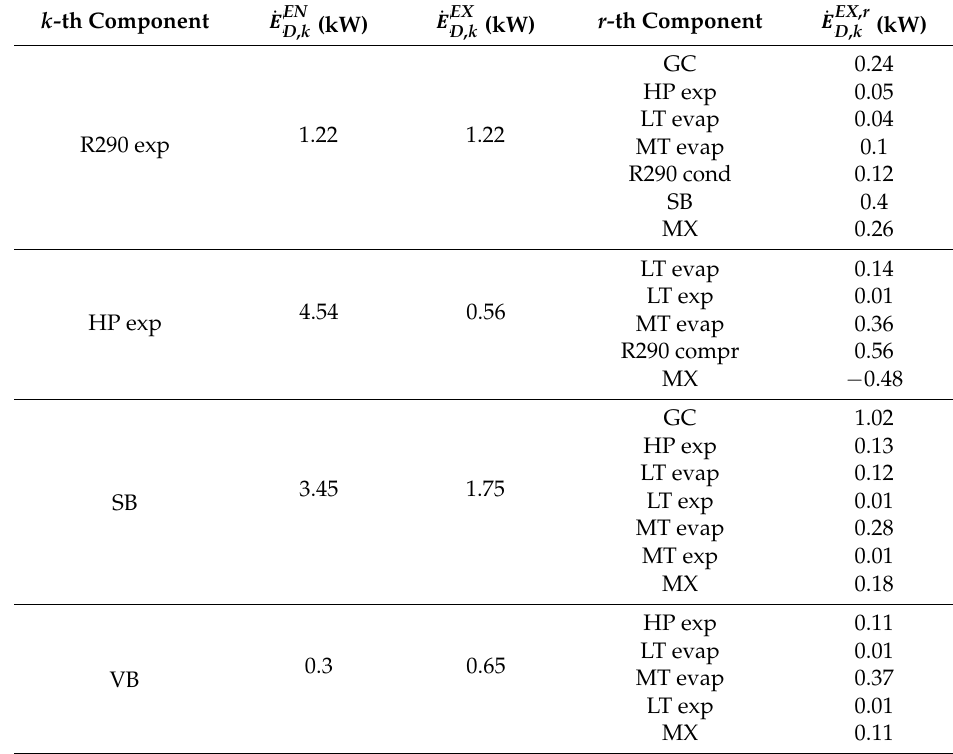
Figure 4. Breakdown of the contribution (%) of each component belonging to DMS to the total exergy destruction rate at the outdoor temperature of 40 °C. Table 8. Results related to the advanced exergy analysis for DMS at the outdoor temperature of 40 °C. k- th Component